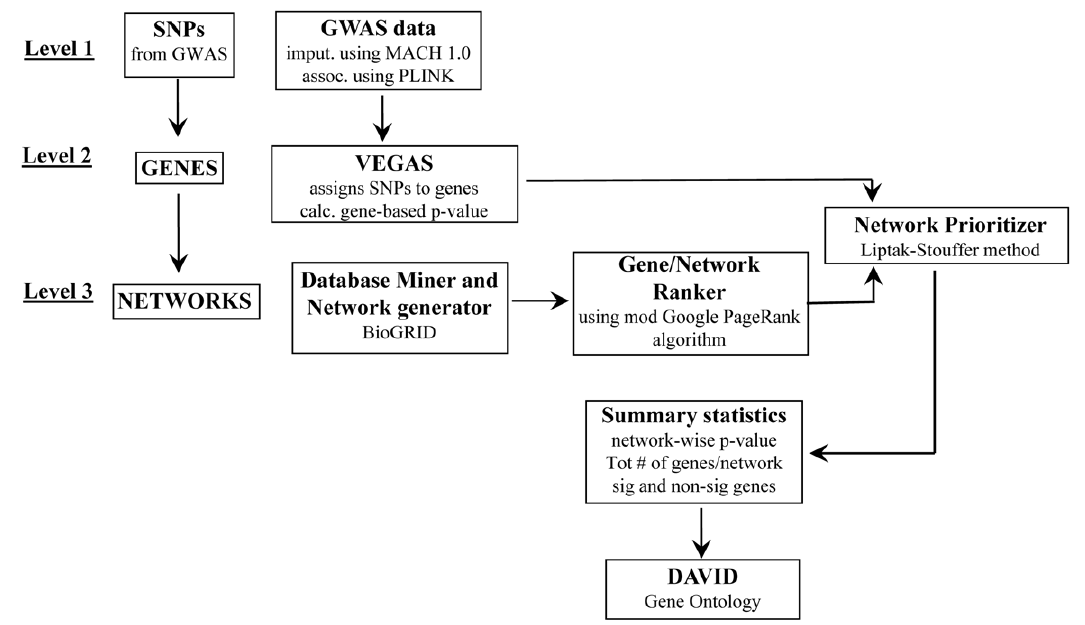
Figure 4. Architecture of Network Interface Miner for Multigenic Interactions (NIMMI). Network Interface Miner for Multigenic Interactions (NIMMI) consists of three levels: SNPs, Genes and Networks, and each level in turn has different modules necessary to prioritize ‘trait prioritized sub- networks’. At the SNPs level (or Level 1), the SNPs are analyzed in the GWAS data module using PLINK. The SNPs are then assigned to genes and a gene-wise p-value is calculated using VEGAS (Level 2). The Database Miner and Network generator module in Networks level (or Level 3) mine the BioGRID database for human PPIs and created two-step networks that are then ranked using the modified Google PageRank algorithm in the Gene/ Network ranker and prioritizer module. The association p-value of a gene from Level 2 and gene weight from Level 3 are then combined using the Liptak-Stouffer method. The resulting ‘trait prioritized sub-networks’ are then evaluated in DAVID.